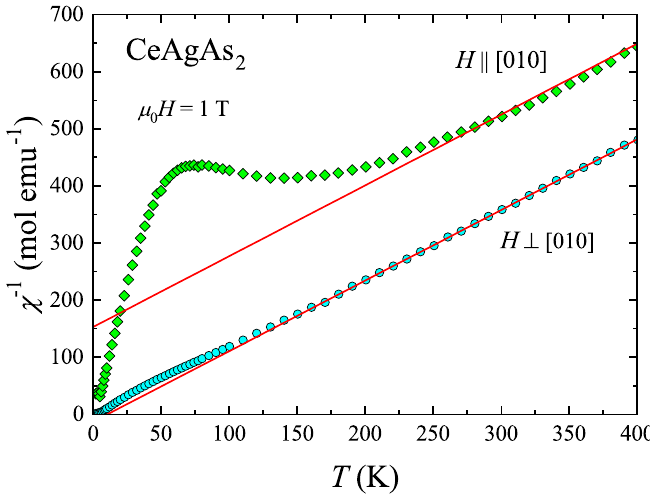
Figure 1. Temperature dependencies of the reciprocal magnetic susceptibility of single-crystalline CeAgAs 2 , measured at constant field oriented parallel and perpendicular to [010] direction. The solid lines represent the fits of the Curie–Weiss law to the experimental data, respectively.